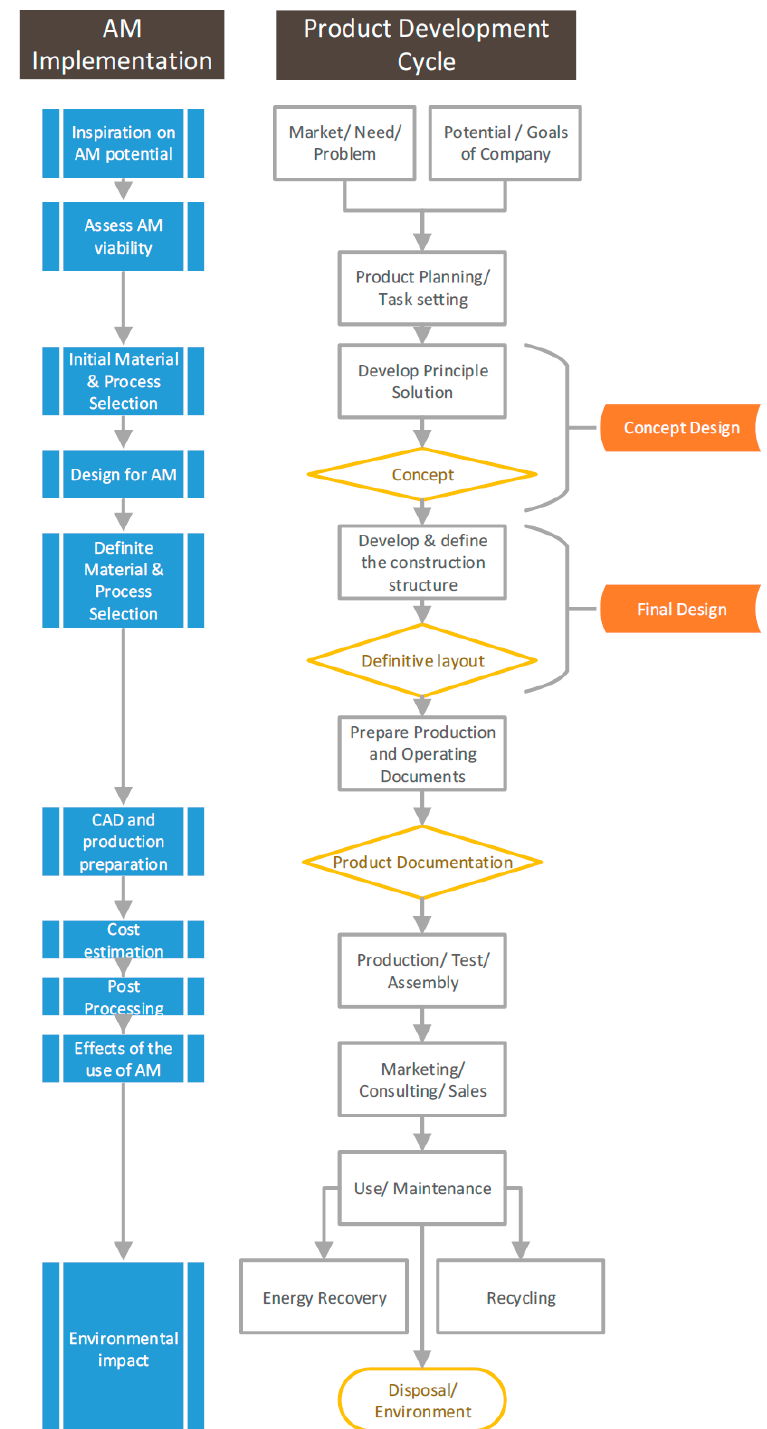
Figure 2. AM-related life cycle considerations are redrawn based on [28].